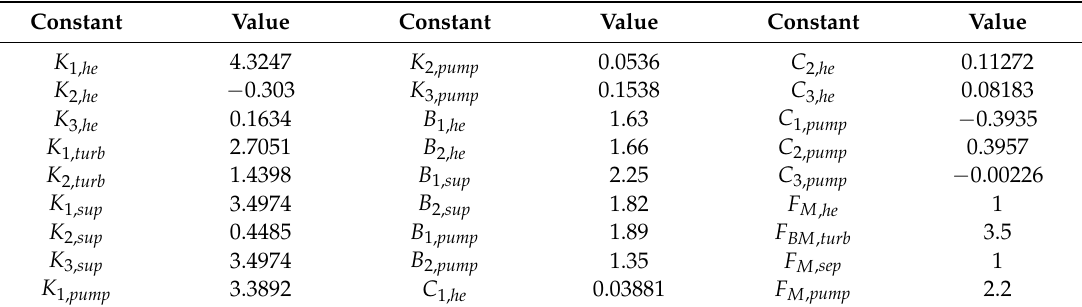
Table 4. Constants for equipment costs calculation